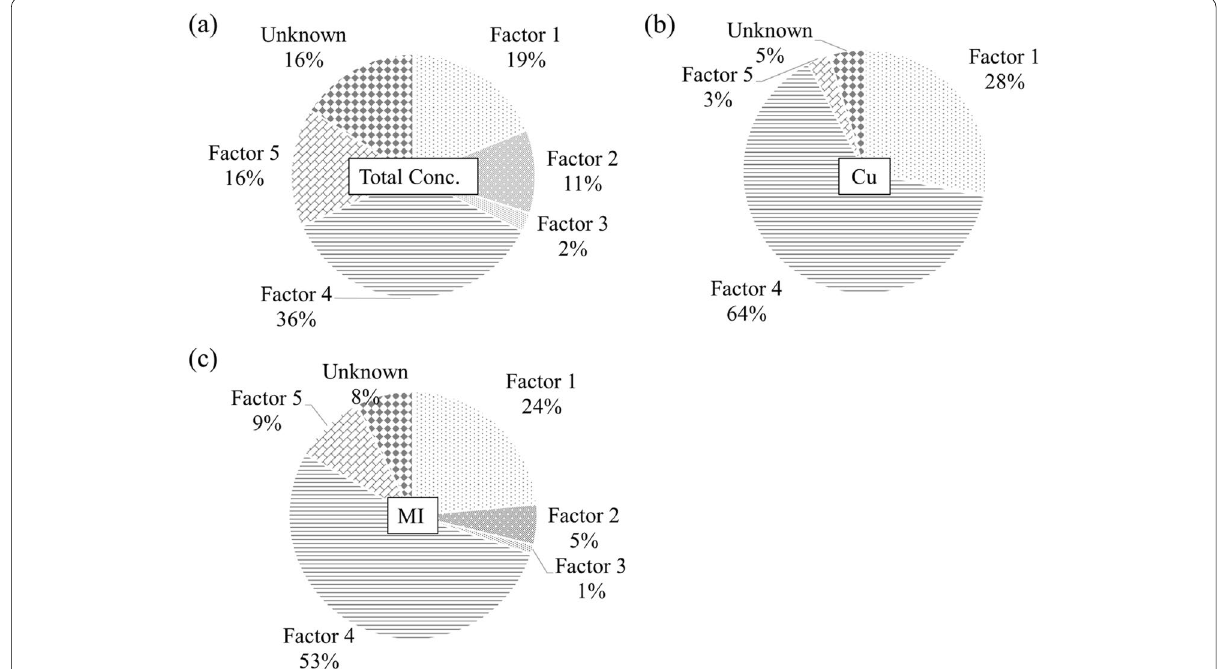
Fig. 5 Source contributions of five factors to ( a ) total elemental concentrations, ( b ) Cu, and ( c ) MI